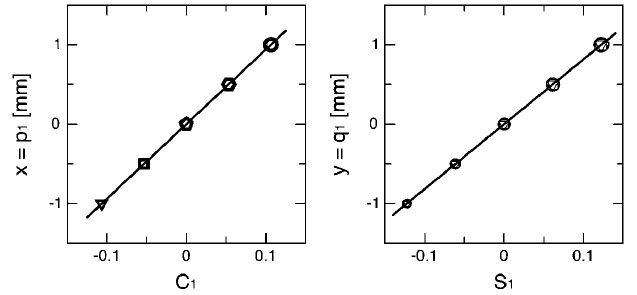
FIG. 10. Relation between p merically calculated BPM with circular cross section.